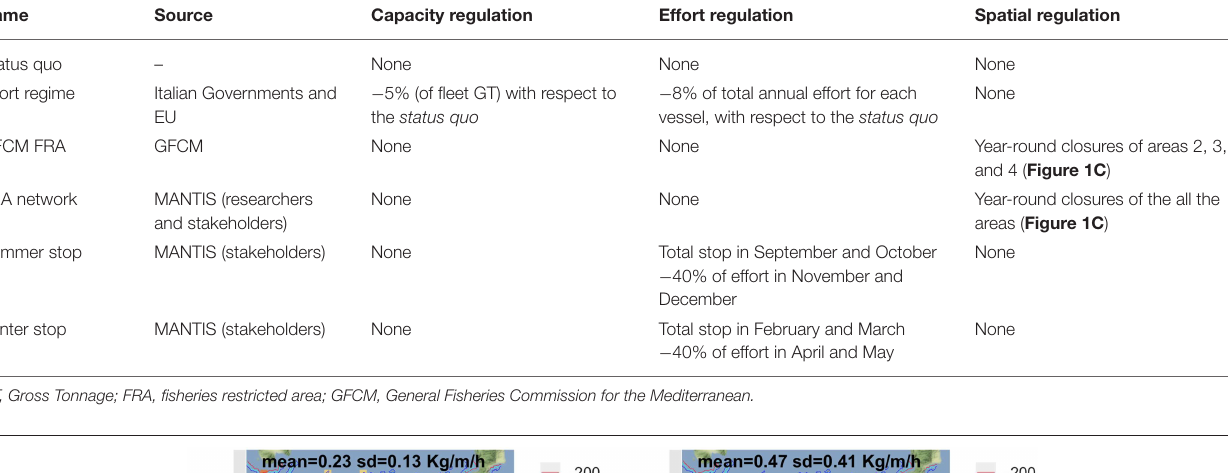
Figure 6 represents, for each species, the mean proportion of catch by age/cell. These closely follow the corresponding patterns of mean LPUE by species ( Figure 5 ). It is worth noting that (1) for ARS, the different age classes were consistently overlapped in the three fishing grounds; (2) DPS showed a progressive shift of the spatial distribution, according to the age, toward deeper areas; (3) HKE cohorts occupied the same fishing grounds of DPS, but with different proportion according to age; (4) given the lack of information on the coastal areas off Tunisia and Libya, the first cohort of MUT seems to be present only near the Sicilian coast, whereas older age classes are progressively concentrated in the offshore margin of the Adventure Bank and Tunisian